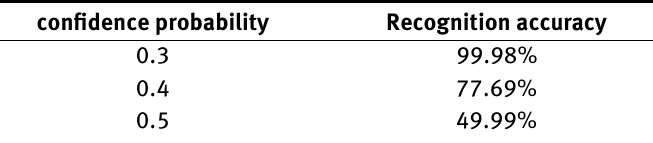
Table 9: The effect of confidence probability on the